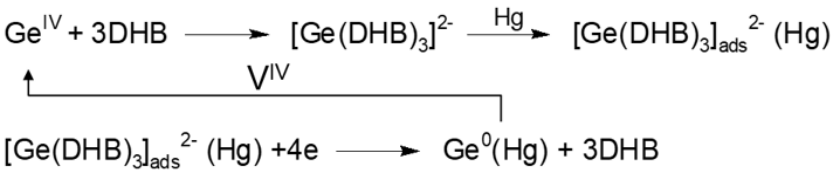
Figure 6. ( a ) CV voltammograms recorded for: (1) 0.1 M of KCl, 1 mM of DHB, 2 mM of EDTA and 10 nM of Ge(IV) (pH = 2.2) (1), (2) — as for (1), but with an additional 3mM of V(IV). Instrumental parameters: scan rate = 100 mVs − l , E acc = − 0.25 V, t acc = 30 s. Reprinted from [42] with permission from Elsevier. ( b ) DP voltammograms of (1) 0.05 M of acetate buffer and 20 nM of Ge, (2) — as for (1), but with the addition of 1.0 mM of catechol, (3) — as for (2), but with the addition of 1 mM of V(IV) and 1.5 mM of EDTA. Instrumental parameters: E acc = − 0.2 V, t acc = 80 s [40]. ( c ) DP voltammograms of (1) 0.05 M of acetate buffer and 20 nM of Ge, (2) — as for (1), but with the addition of 1.5 mM of catechol, (3) — as for (2), but with the addition of 1mM of V(IV) and 1.5 mM of HEDTA. Instrumental parameters: E acc = − 0.2 V, t acc = 80 s. Adapted with permission from ref.